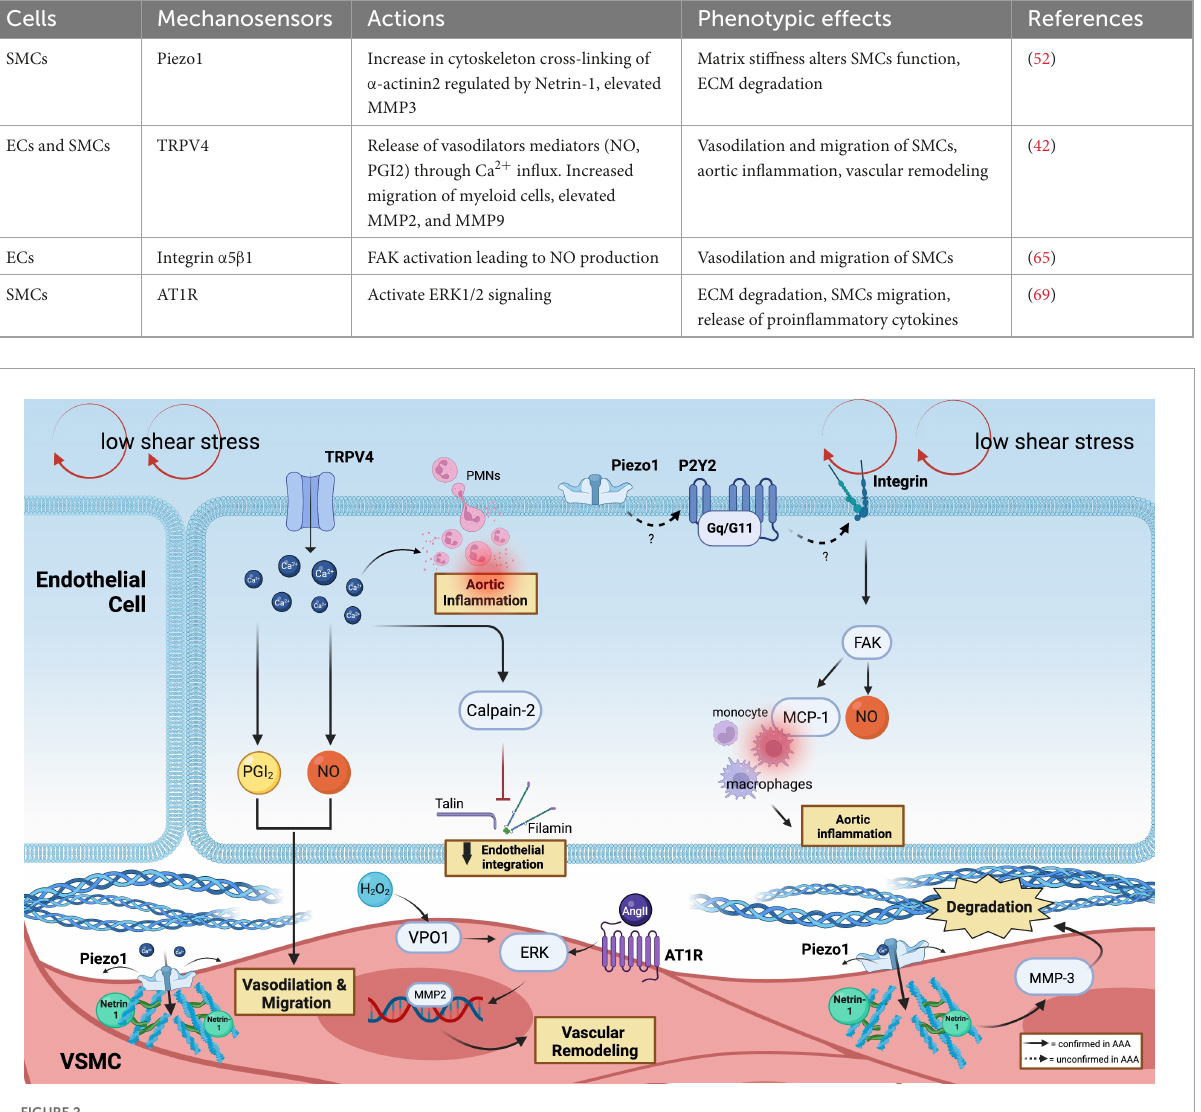
FIGURE2 Mechanoreceptors involved in AAA. In the ECs, low shear stress is sensed by the ion channel (TRPV4 and Piezo1) and purinergic-coupled receptors (P2Y2-Gq11). Through Ca 2 + -responses, which produce PGI 2 and NO, SMCs vasodilate and migrate, followed by the release of calpain-2 that induce the loss of endothelial integration. Ca 2 + flux facilitates PMNs infiltration and inflammation. P2Y2-Gq11 is predicted to activate integrin, which can drive FAK activation. FAK plays a vital role in mediating and recruitment of macrophages via MCP-1 and participating in the production of NO. Netrin-1 promotes Piezo1 opening in SMCs, which activates MMP3 and causes collagen degradation. PECAM-1, VE-cadherin, and VEGFR2 can further activate FAK and MCP-1 secretion that recruits macrophages. The phenotypic switching of SMCs is induced by the H 2 O 2 / VPO1/ERK pathway in AAA and via AT1R